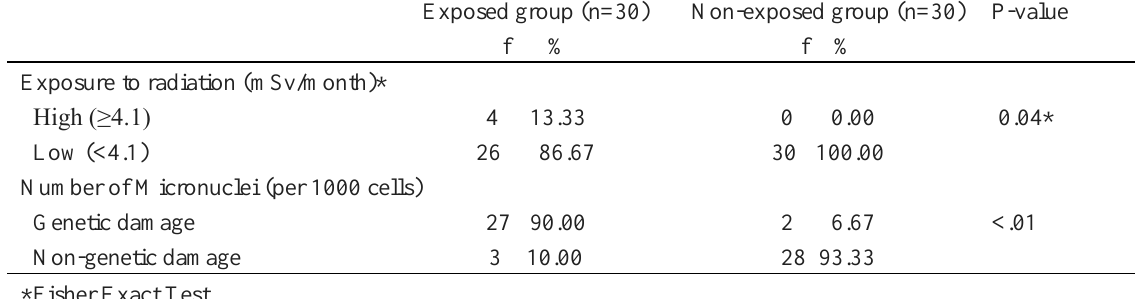
Table 2 . Distribution of exposure to ionizing radiation and genetic damage by the exposure group unsafe level of exposure (13% vs 0%) based on the Official Mexican Standard -SSA1-2002, Environmental Health 12